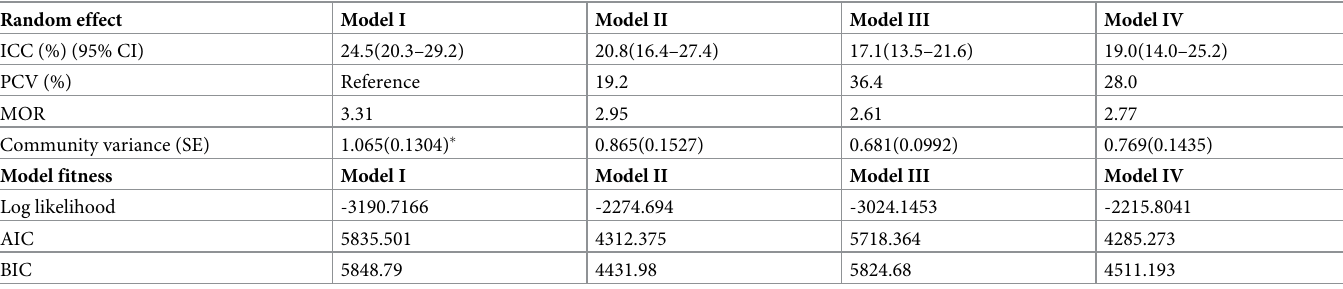
Table 2. Random effect and model comparison for factors associated with risky sexual behavior among sexually active unmarried men in Ethiopia, 2016.